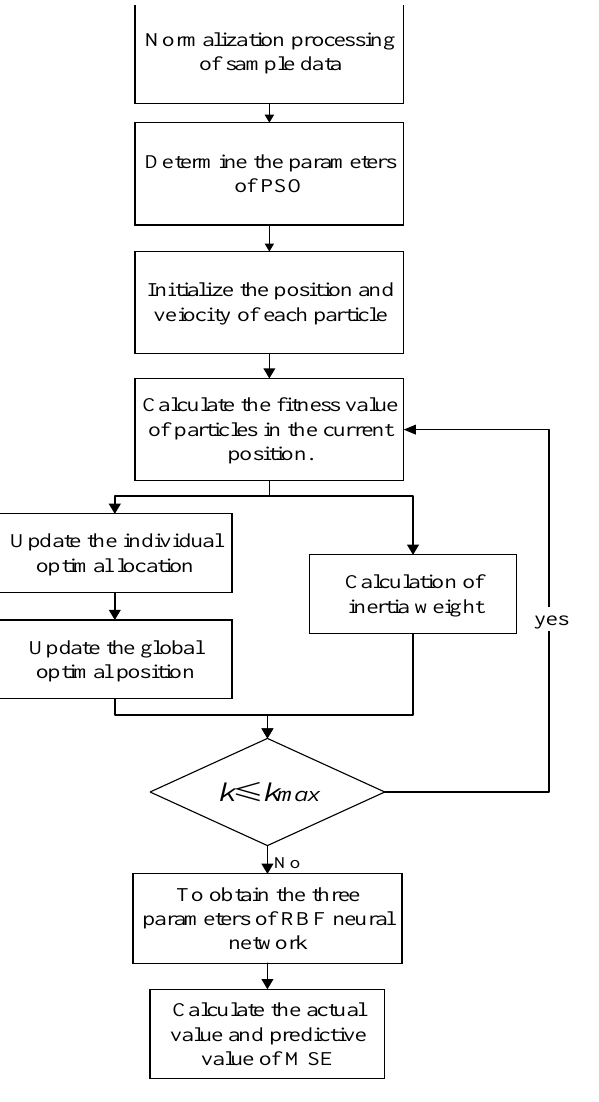
Figure 7. Flow chart of digital construction quality evaluation model for asphalt pavement based on IPSO-RBF.